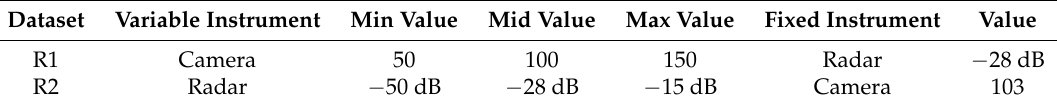
Figure 10. Dissipation rate maps obtained with different thresholds. ( Top ) row corresponds to results varying I t (c.f. Table 3) and ( bottom ) row varying σ t . Threshold values increase from ( left ) to ( right ). 0 Note colorscale differs from other figures. Table 3. Summary of thresholds used in sensitivity